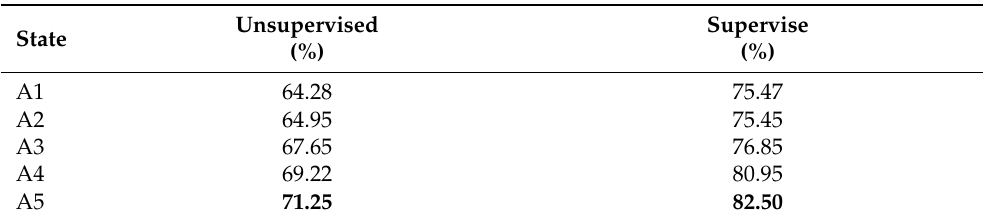
Table 3. Comparison between different setups of our approach in terms of accuracy (%). (Best values highlighted in